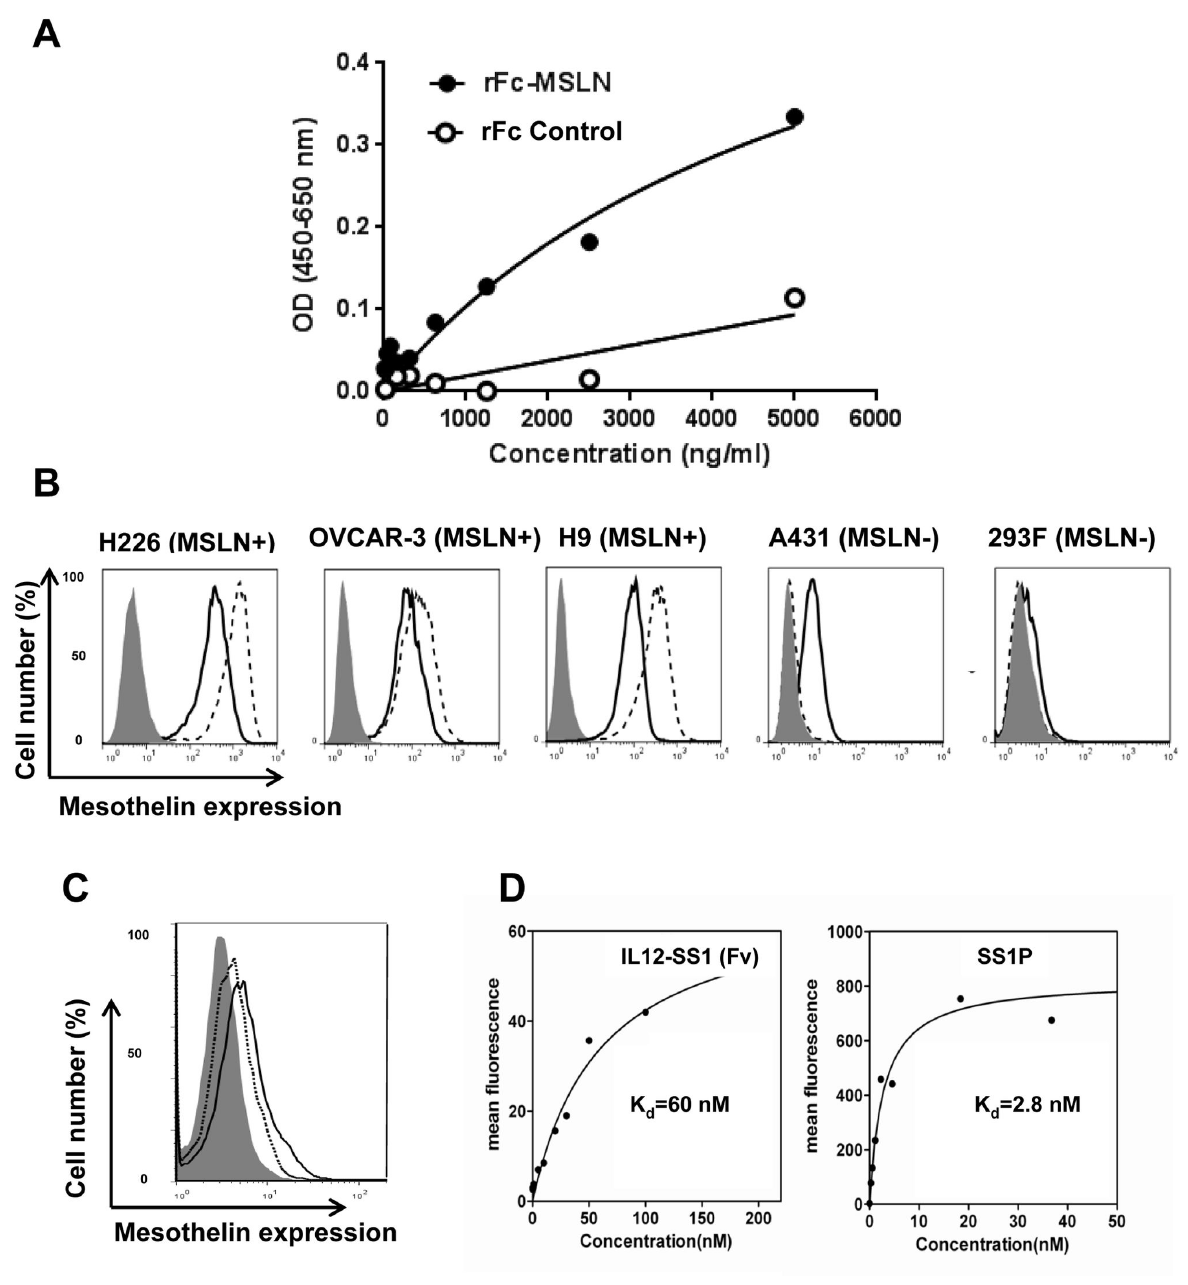
Figure 2. Binding of IL12-SS1 (Fv) to MSLN and cancer cells. (A) The binding specificity of IL12-SS1 (Fv) on MSLN was detected by ELISA. (B) FACS analysis of IL12-SS1 (Fv) on mesothelin-expressing cancer cells. NCI-H226, OVCAR-3, H9, A431, and HEK-293 cells were stained with IL12-SS1 (Fv) which was detected by PE-conjugated anti-histidine antibody (solid line). Mesothelin expression was detected by a mouse anti-MSLN antibody (MN, dotted line) or an irrelevant isotype mAb control (gray surface). Samples were analyzed by flow cytometry. H9: the transfected A431 cell line stably expressing mesothelin; OVCAR-3: human ovarian cancer cell lines; NCI-H226: human mesothelioma cell lines; HEK-293: human embryonic Kidney cell lines. (C) FACS analysis of IL12-SS1 (Fv) on A431 cells. A431 cells were stained with IL12-SS1 (Fv) in the presence of (dotted line) or the absence of (solid line) an anti-IL12R β2 blocking antibody. The binding of IL12-SS1 (Fv) was detected by FITC-conjugated anti-Flag antibody. (D) SS1P and IL12-SS1 (Fv) bound to H9 cells in a dose-dependent manner. H9 cells were stained with indicated concentrations of IL12-SS1 (Fv) and then detected by flow cytometry. The K value for SS1P and IL12-SS1 (Fv) binding to H9 cells d are approximately 2.8 and 60 nM, respectively. doi: 10.1371/journal.pone.0081919.g002 PLOS ONE |